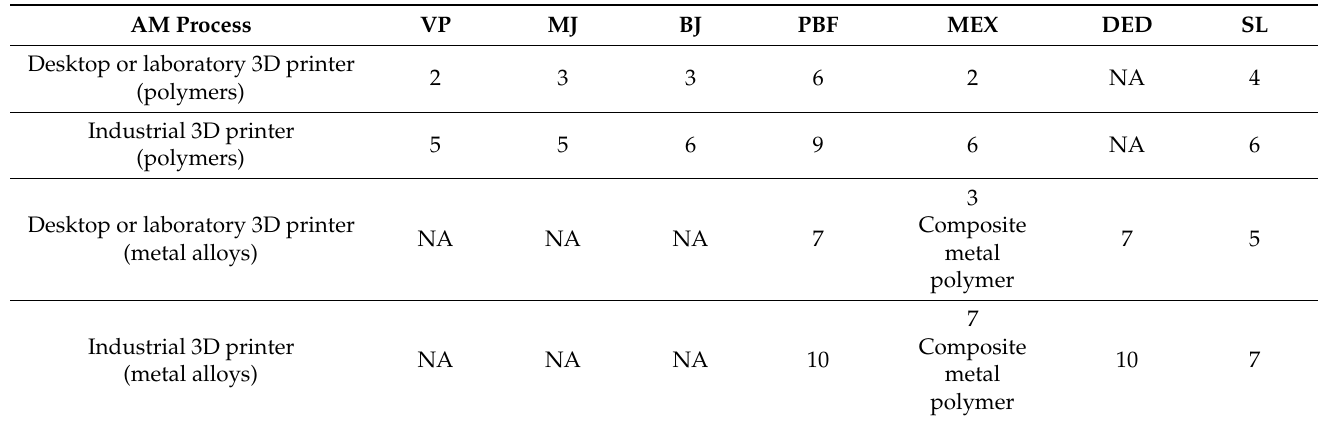
Table 3. Energy demand of